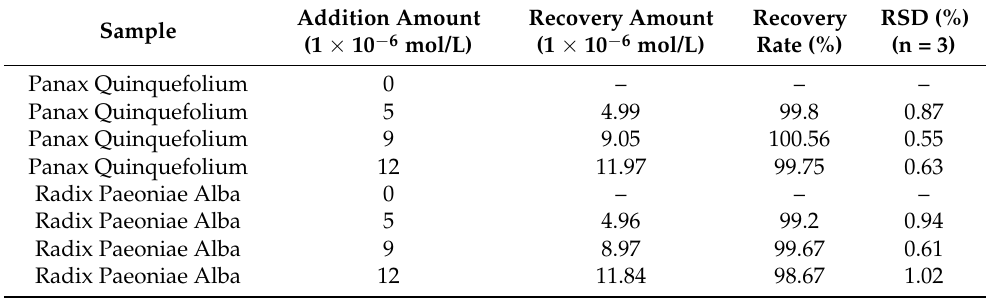
Table 3. Sample measurement results. (n = 8) .